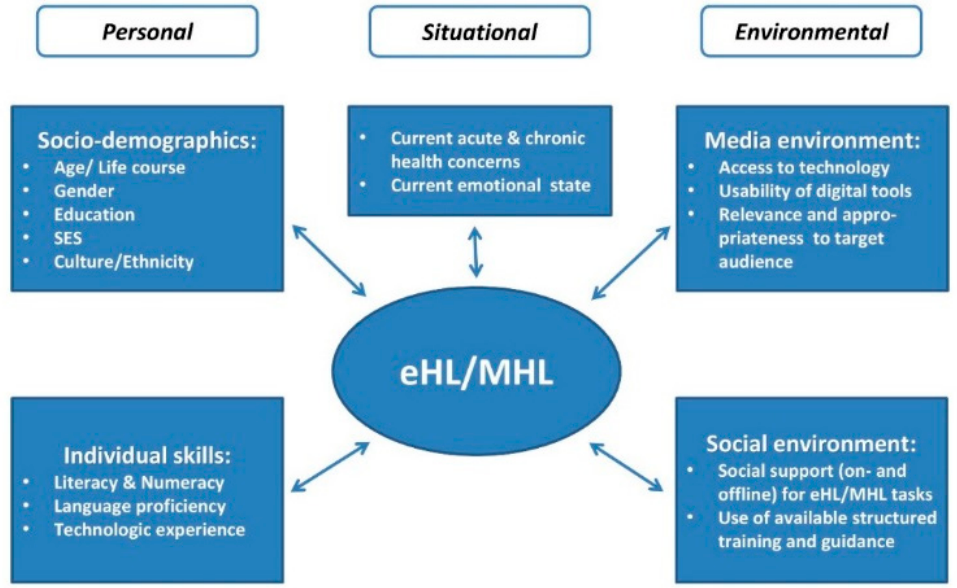
Figure 1. The complexity of eHealth Literacy (eHL) and Media Health Literacy (MHL) in context.